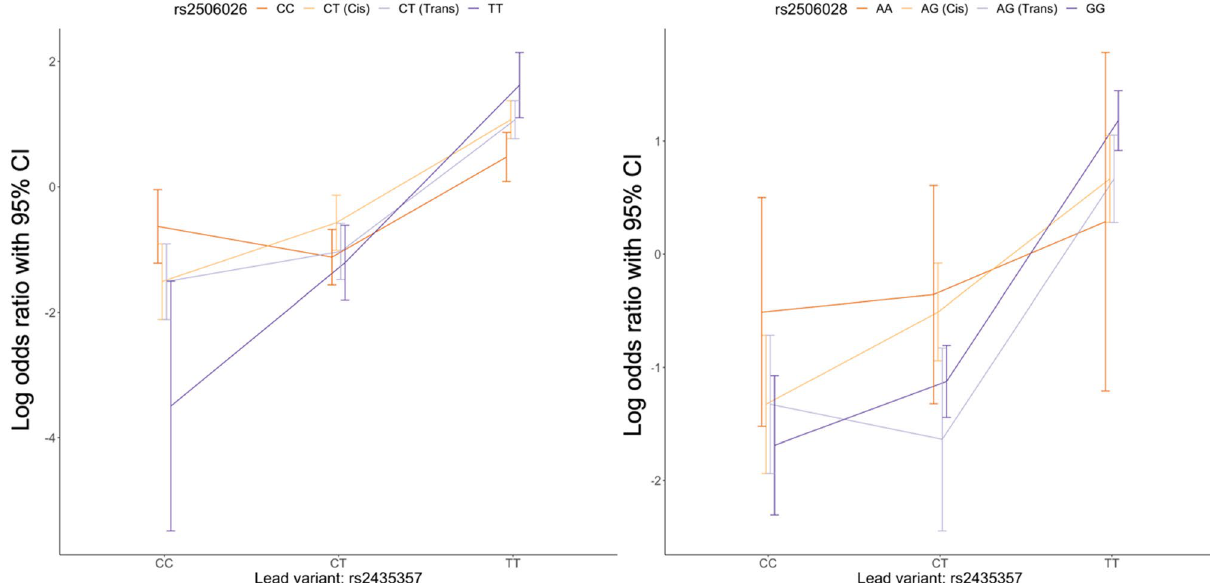
Figure 3. The epistatic effects in log odds between the two representative epistatic variants with the lead variant (rs2435357) in RET. On the left panel, CT (Cis) refers to the scenario where the risk allele (T) in rs2506026 and the risk allele (T) in rs2435357 are inherited from the same parent; CT (Trans) refers to the scenario where the risk allele (T) in rs2506026 and the risk allele (T) in rs2435357 are inherited from the different parents; Similarly, on the right panel AG (Cis) refers to the scenario where the risk allele (A) in rs2506028 and the risk allele (T) in rs2435357 are inherited from the same parent; AG (Trans) refers to the scenario where the risk allele (A) in rs2506028 and the risk allele (T) in rs2435357 are inherited from the different